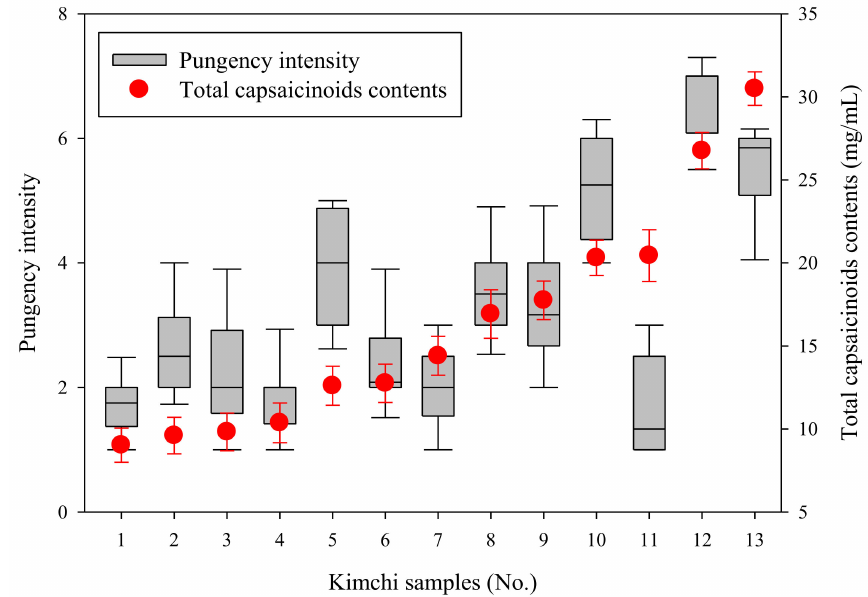
Figure 2. Sensory spiciness evaluation of commercial kimchi samples (left Y -axis). Total capsaicinoid content of commercial kimchi samples (right Y -axis). The results of sensory evaluation assessing the spiciness and mean capsaicinoid content of our kimchi samples are represented in box plots and scatter plots, respectively. The box plots show the lowest, median, and highest data points, as well as the spread and distribution of spiciness intensity